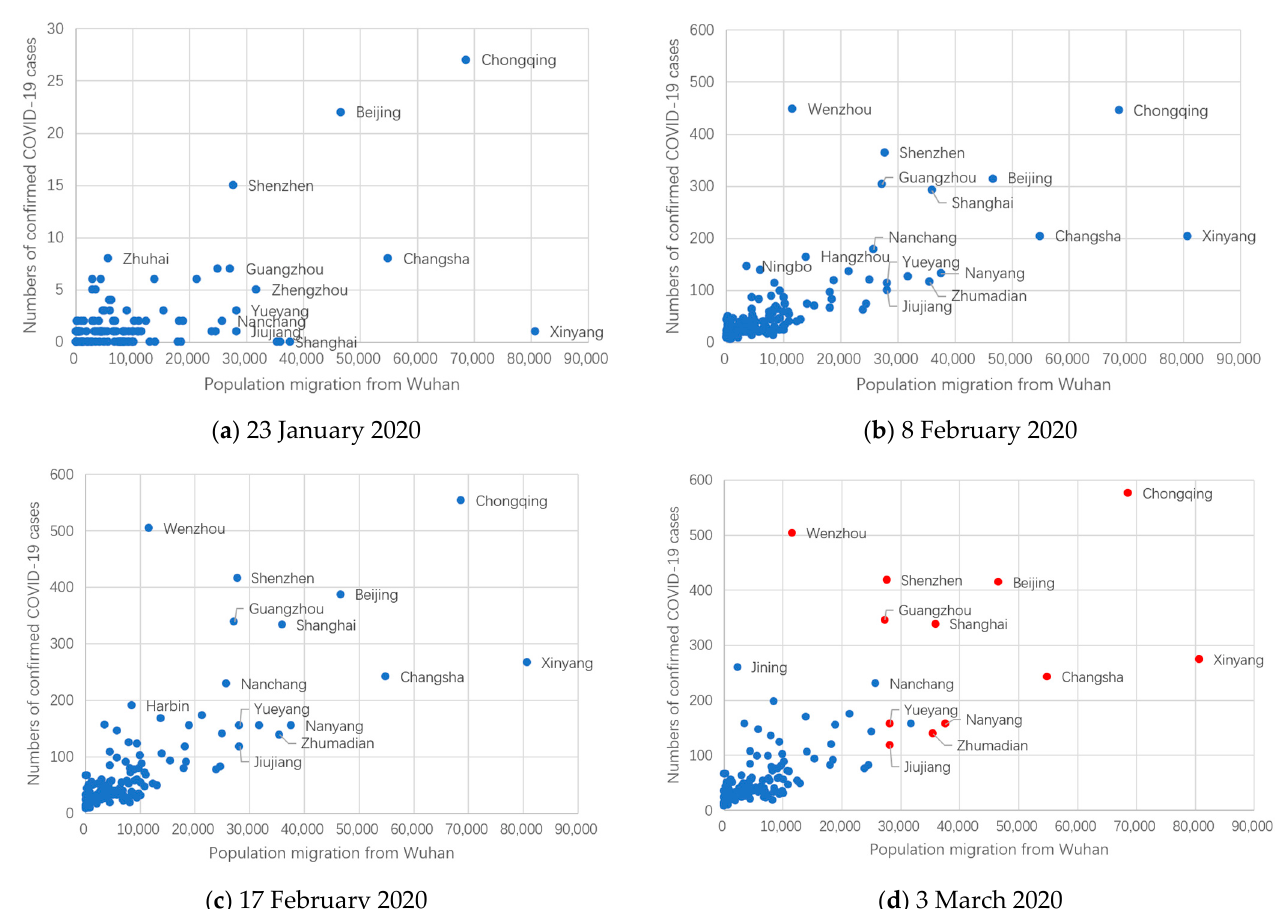
Figure 7. Numbers of confirmed COVID-19 cases and population migration from Wuhan for cities outside of Hubei. The x -axis shows the estimated population migration from Wuhan to different cities and the y -axis shows the accumulated number of confirmed COVID-19 cases in different cities. ( a ) 23 January 2020; ( b ) 8 February 2020; ( c ) 17 February 2020; ( d ) 3 March 2020.The red dots in ( d ) show the key cities that were focused on in this